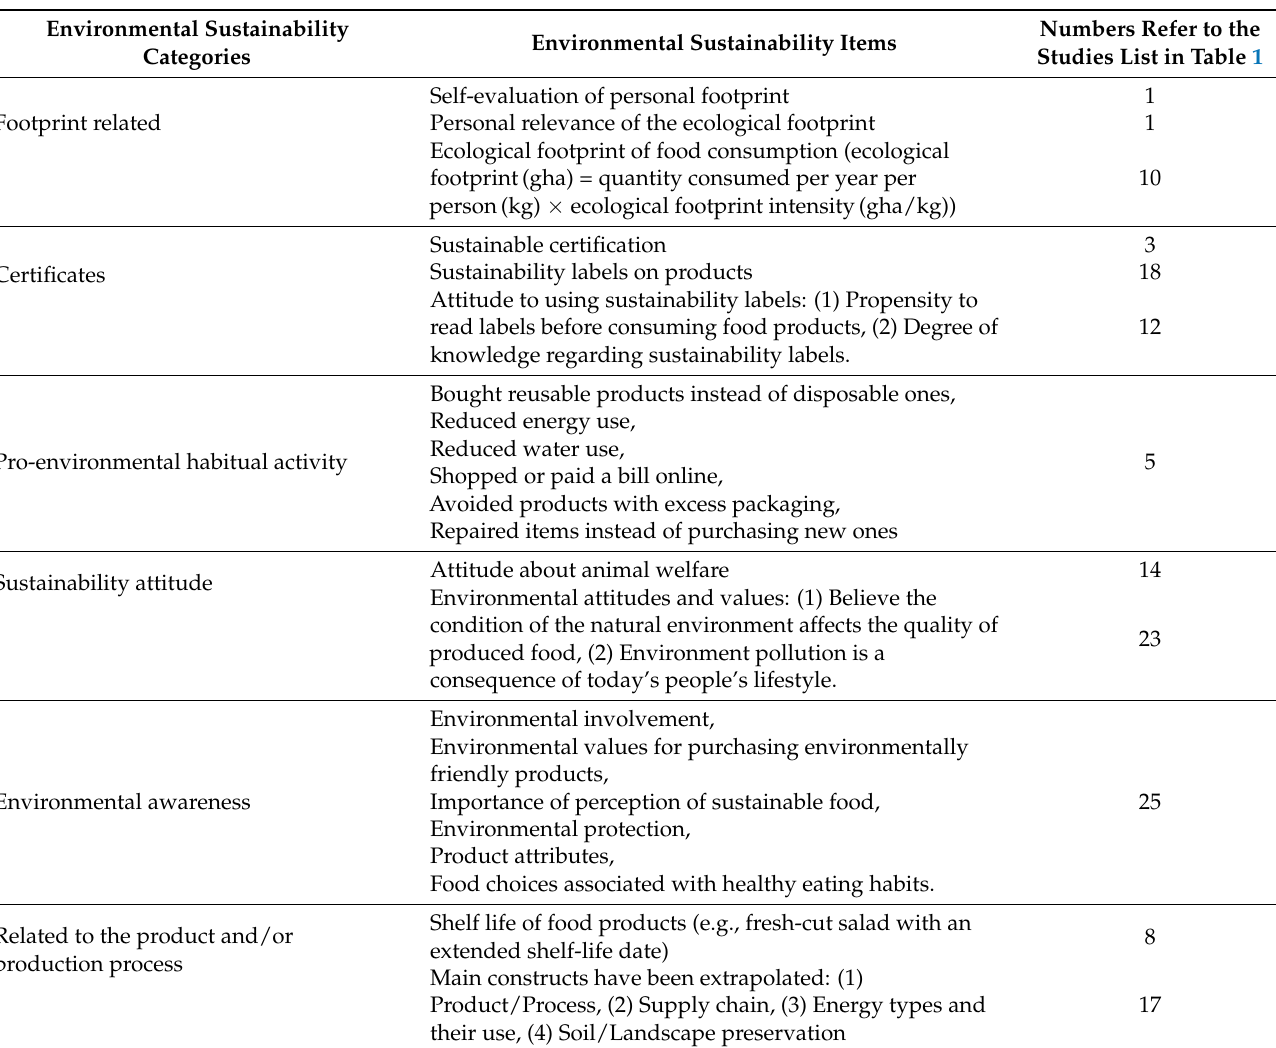
Table 3. Environmental sustainability factors used in the analyzed